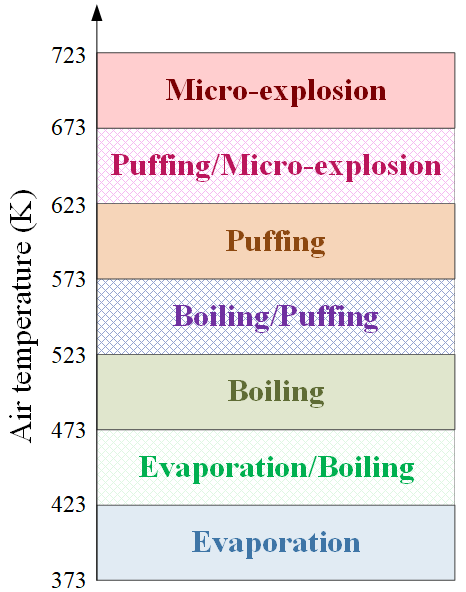
Figure 3. Temperature ranges of micro-explosion regimes of two-liquid droplets (95% of distilled water/5% of kerosene, V d = 15 ± 1 μL, U a = 2 ± 0.1 m/s) singled out by analyzing the research findings from Ref. [141].